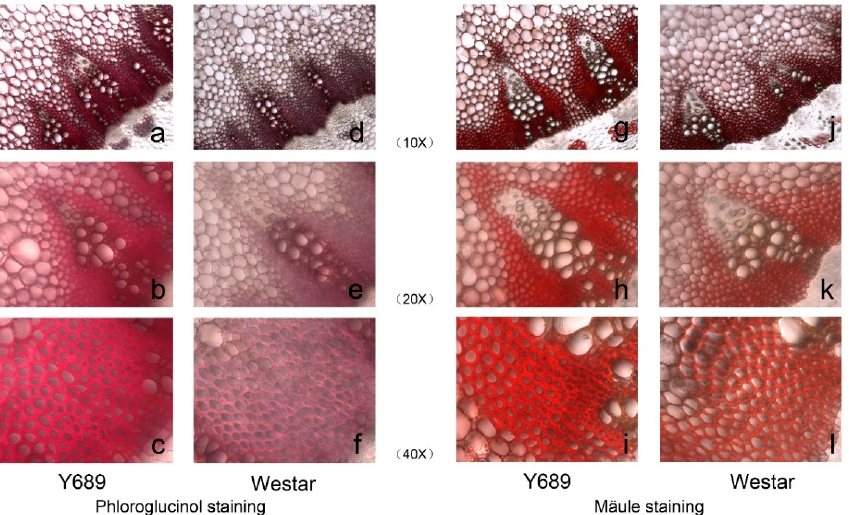
Figure 2. Phloroglucinol and Mäule staining of ‘Y689’ and ‘Westar’. ( a – c ) Transverse internode sections of ‘Y689’ after phloroglucinol staining. ( d – f ) Transverse internode sections of ‘Westar’ after phloroglucinol staining. The lignin quantity of ‘Y689’ is more than ‘Westar’. ( g – i ) Transverse internode sections of ‘Y689’ after Mäule staining. ( j – l ) Transverse internode sections of ‘Westar’ after Mäule staining. The Mäule reagent stains: G residues yellow and S residues red. Magnification 10 × , 20 × , and 30 × . Table 1. Statistical analysis of ADL, Cel, Hem, SG, BF, F and SSR for the DH lines and their